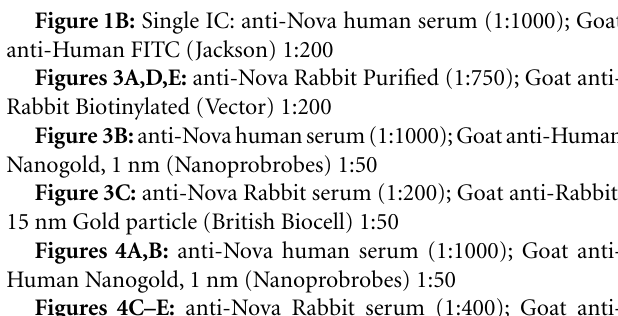
Figure 1B: Single IC: anti-Nova human serum (1:1000); Goat anti-Human FITC (Jackson) 1:200